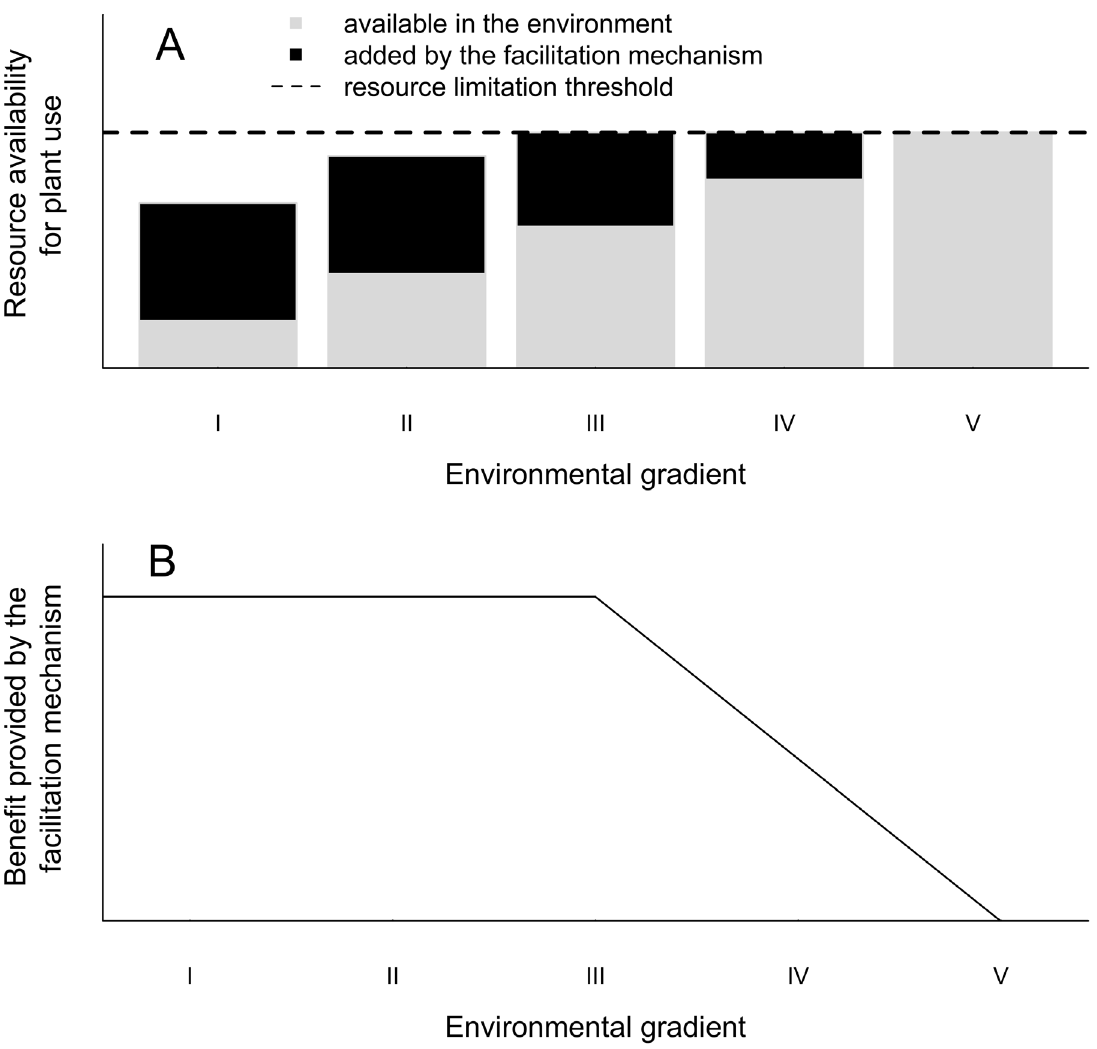
Figure 4. A graphical model of the stress gradient hypothesis regarding facilitation mechanism, which shows how a constant facilitation effect can occur along an environmental gradient. A) A gradient is defined by the monotonic variation in the availability of a resource (gray bars), which increases by a constant amount due to a plant facilitation mechanism (black bars). The dashed line represents the resource limitation threshold: below this line, the resource is limiting, and above this line, the resource is not limiting. B) The relationship between the environmental gradient (as described for graph A) and the benefits provided by the additive facilitation effect. Note that in the region of the gradient where the resource is limiting (levels I and II in graph A), the benefits provided by the facilitator are constant along the environmental gradient (levels I and II in the graph B). However, from the point where the total availability of the resource (from the environment and the facilitator) reaches the resource limitation threshold (gradient level III), further increases in the resource availability along the gradient will reduce the portion of the